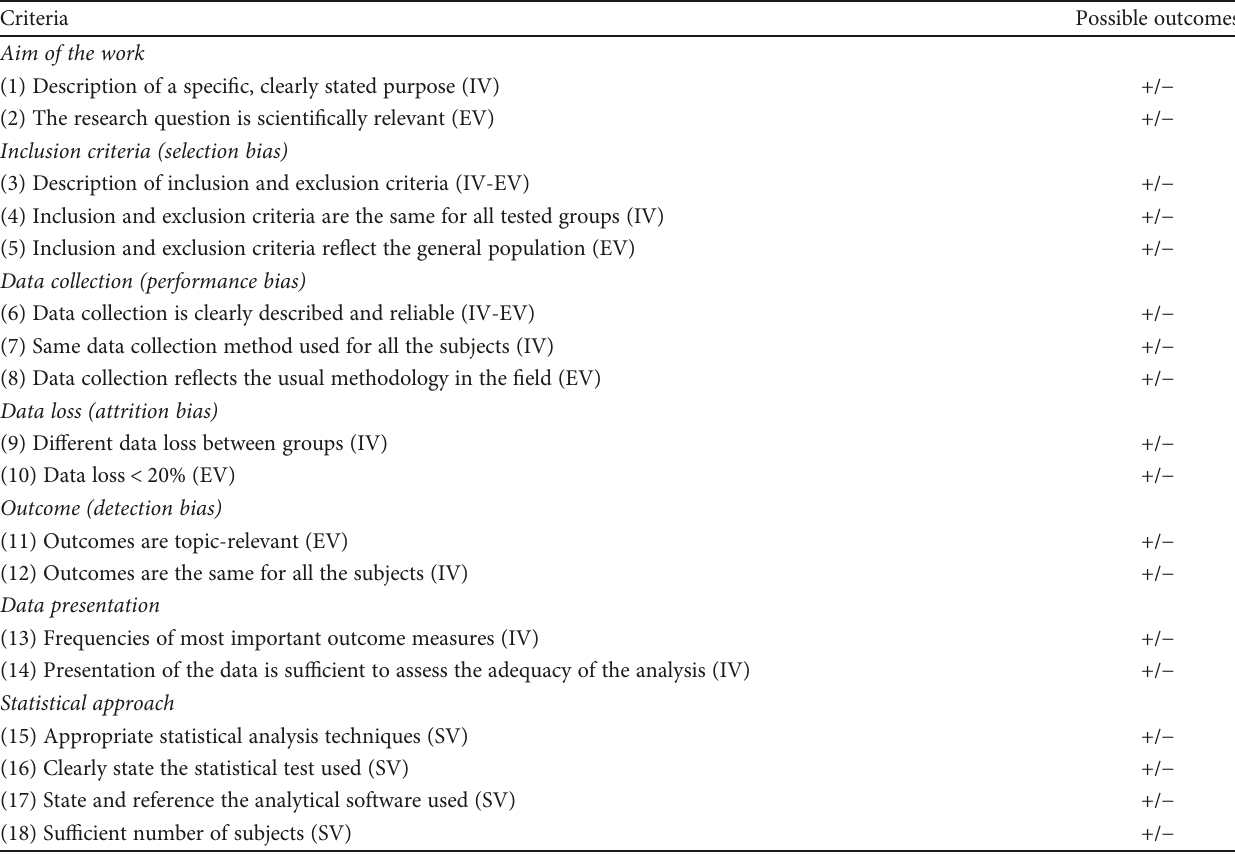
Criteria Possible outcomes Aim of the